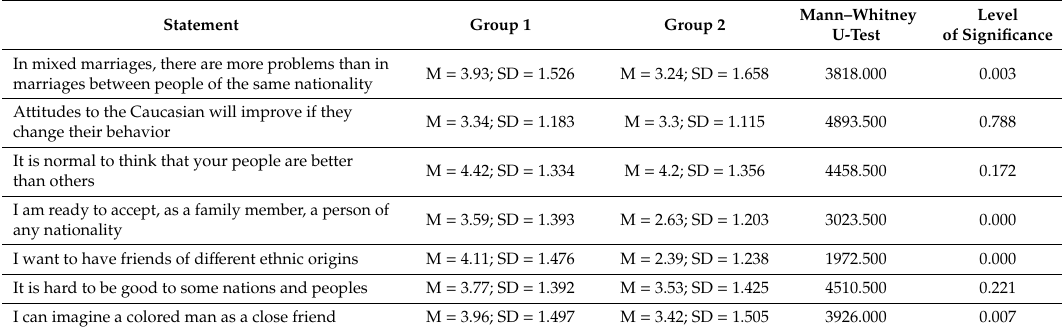
Table 4. The comparative analysis of the responses of the respondents from regions with varying ethnic diversity (n1 = 100, n2 =